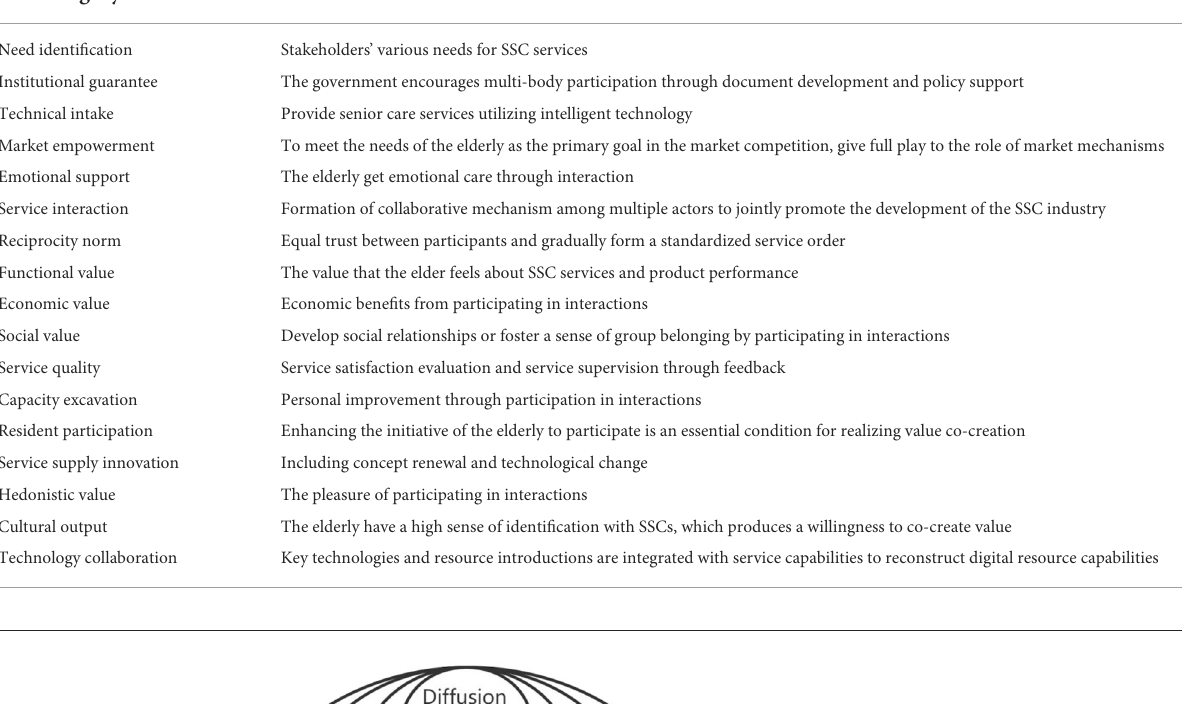
TABLE 4 Definition of sub-category.